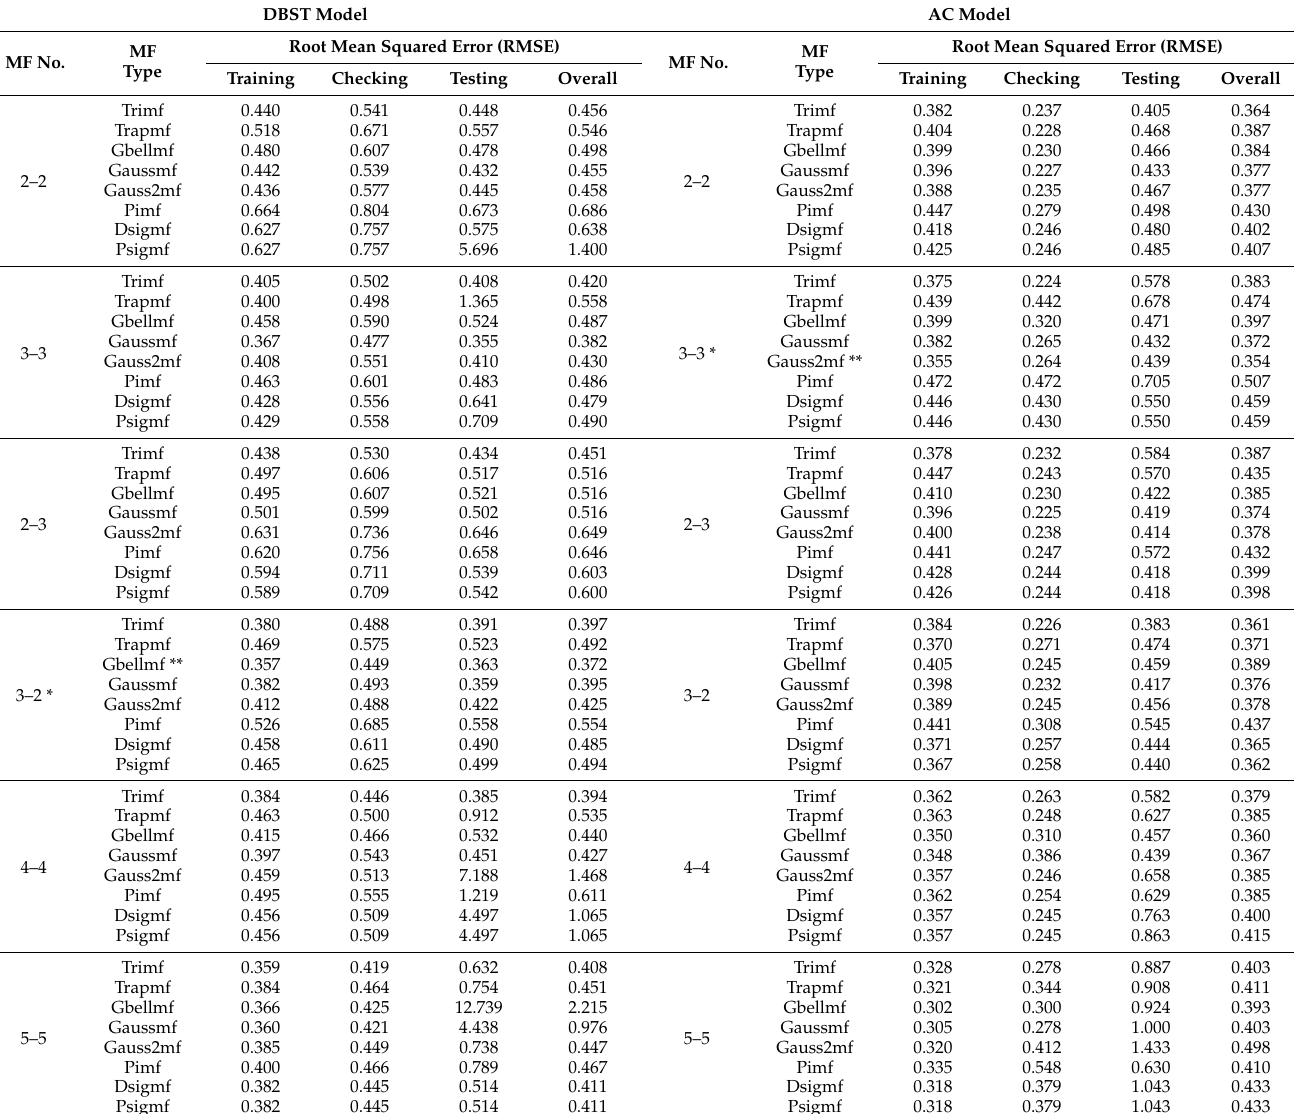
Table 3. Performance of different models under various MF numbers and types for DBST and AC pavement